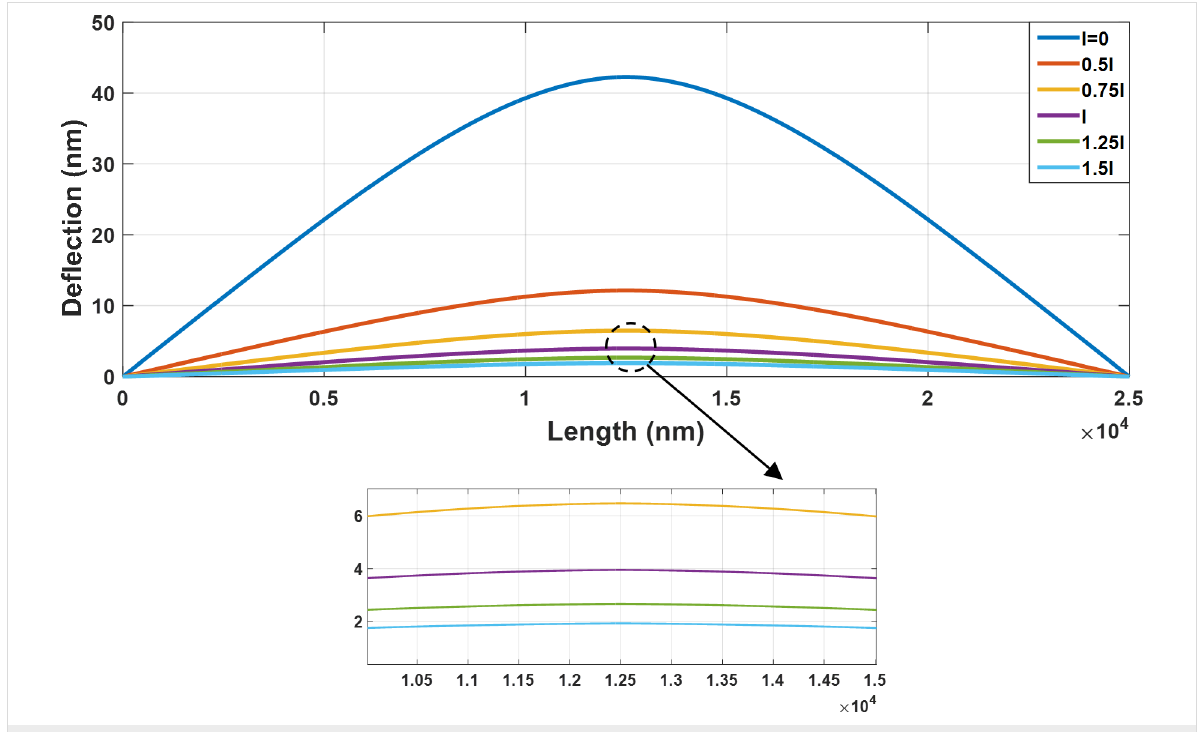
Figure 12: The sensitivity of manipulation dynamics to size effects (length = 25 µm and aspect ratio = 30).